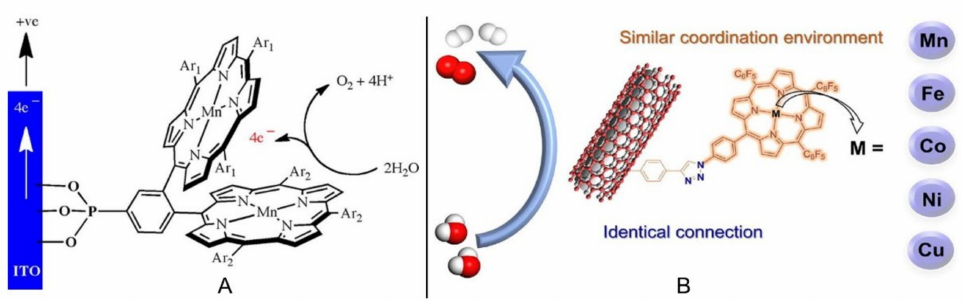
Figure 5. Covalently surface-immobilized porphyrins for electrochemical OER: ( A ) Mn porphyrin dimers (Mn 2 DP-a|ITO, Ar 1 = Ar 2 = C 6 F 5 ; Mn 2 DP-b|ITO, Ar 1 = Ar 2 = C 6 H 2 (CH 3 ) 3 ; Mn 2 DP-c|ITO, Ar 1 = C 6 F 5 , Ar 2 = C 6 H 2 (CH 3 ) 3 ; Mn 2 DP-d|ITO, Ar 1 = Ar 2 = C 6 H 4 PO 3 H 2 ) on ITO electrode.